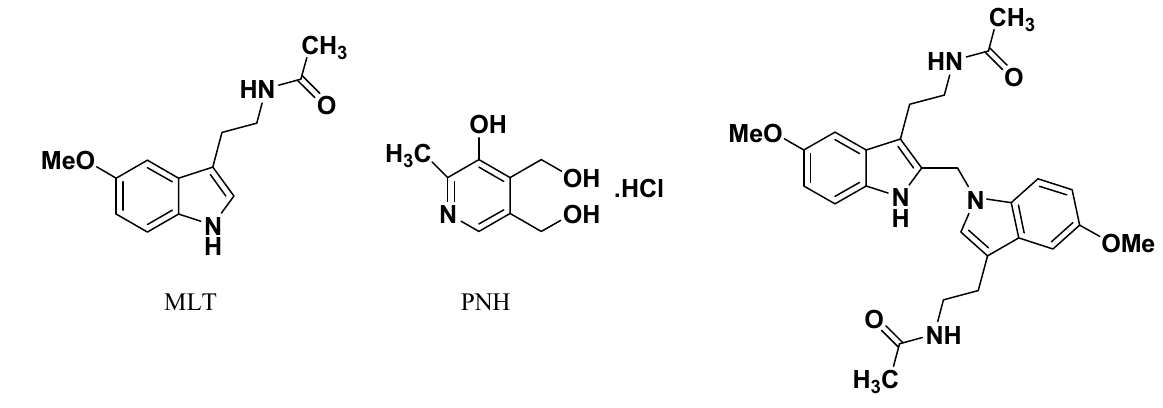
Figure 1. Chemical structures of melatonin (MLT), pyridoxine HCl (PNH), and